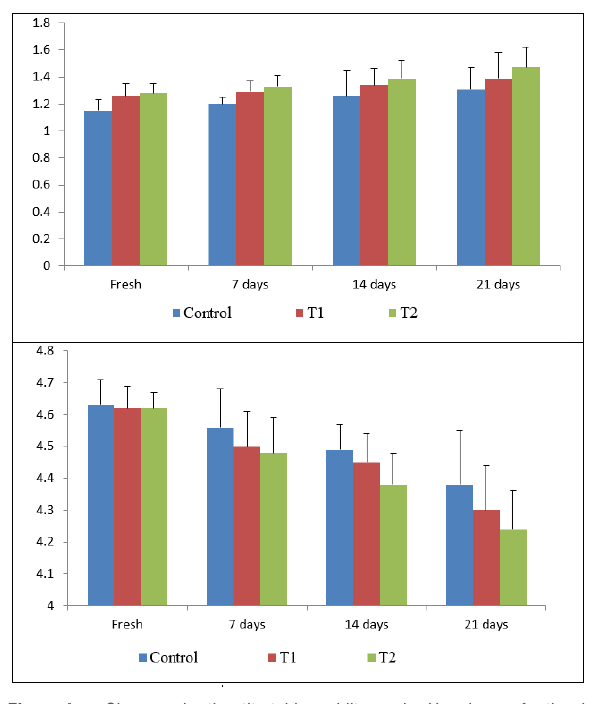
Changes in the titratable acidity and pH values of stirred yoghurt fortified with crude fucoxanthin during 21 days of cold storage. Control: plain yoghurt; T1: yoghurt containing 20 mg crude fucoxanthin / kg milk; T2, yoghurt containing 30 mg crude fucoxanthin / kg milk. Data are expressed as a mean of three replicates ± SD.